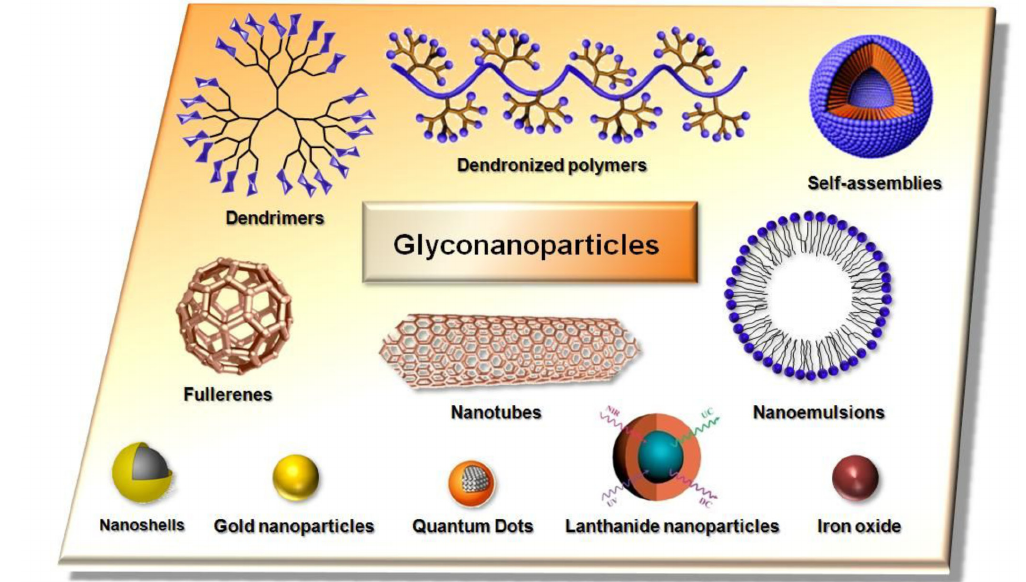
FIGURE 1- Schematic representation of accessible multivalent glyconanoparticles reviewed in this